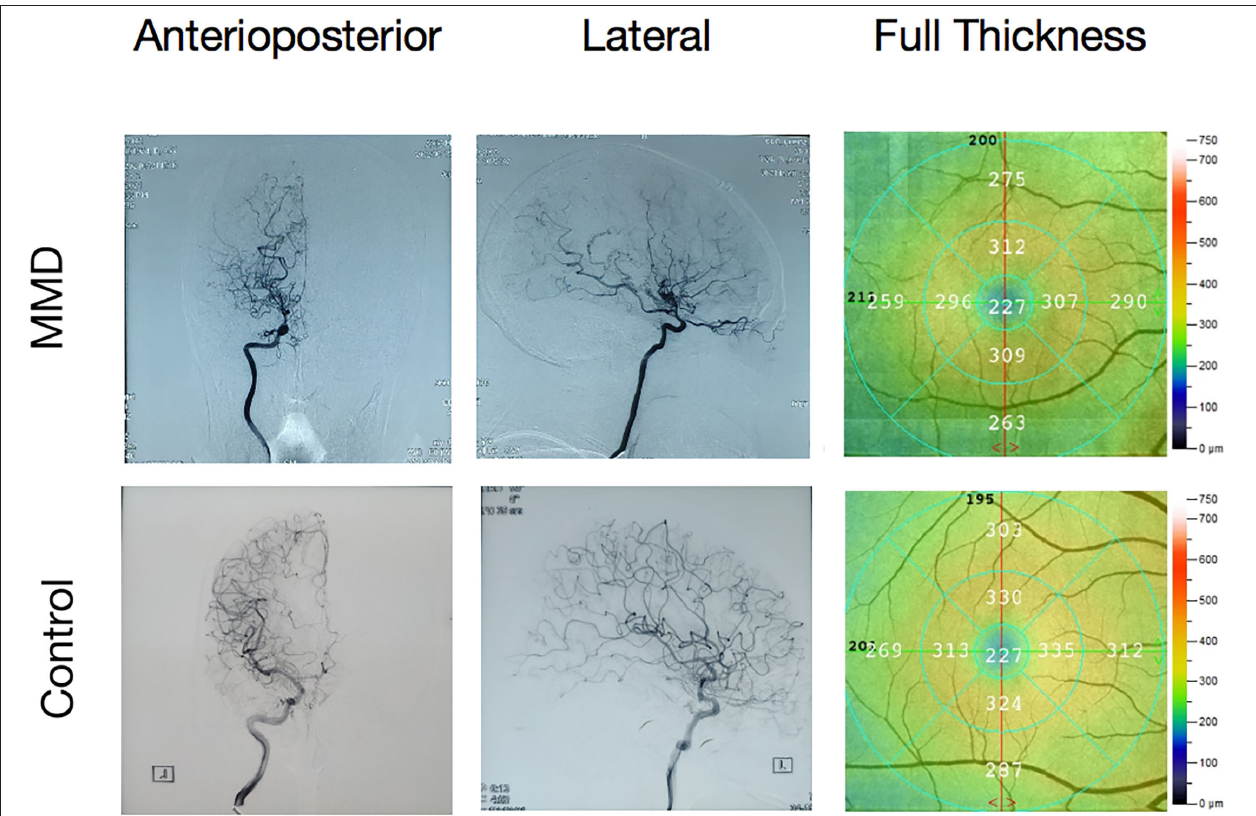
FIGURE 1 | A moyamoya disease (MMD) angiography illustration and a fundus camera illustration. Internal carotid in the digital subtraction angiography (DSA). Undeveloped anterior and middle cerebral arteries and multiple anomalous vascular networks at the base of the